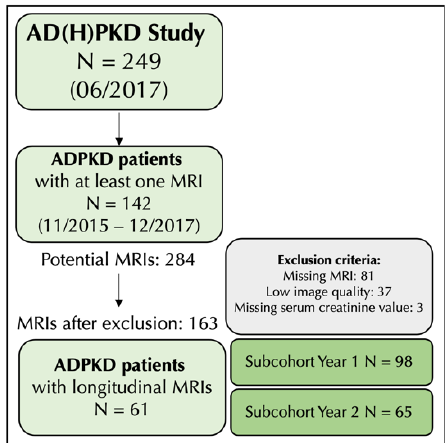
Figure 1. Study flow diagram depicting patient flow, exclusion criteria, and subgroup analyses. ADPKD, autosomal dominant polycystic kidney disease; MRI, magnetic resonance imaging.